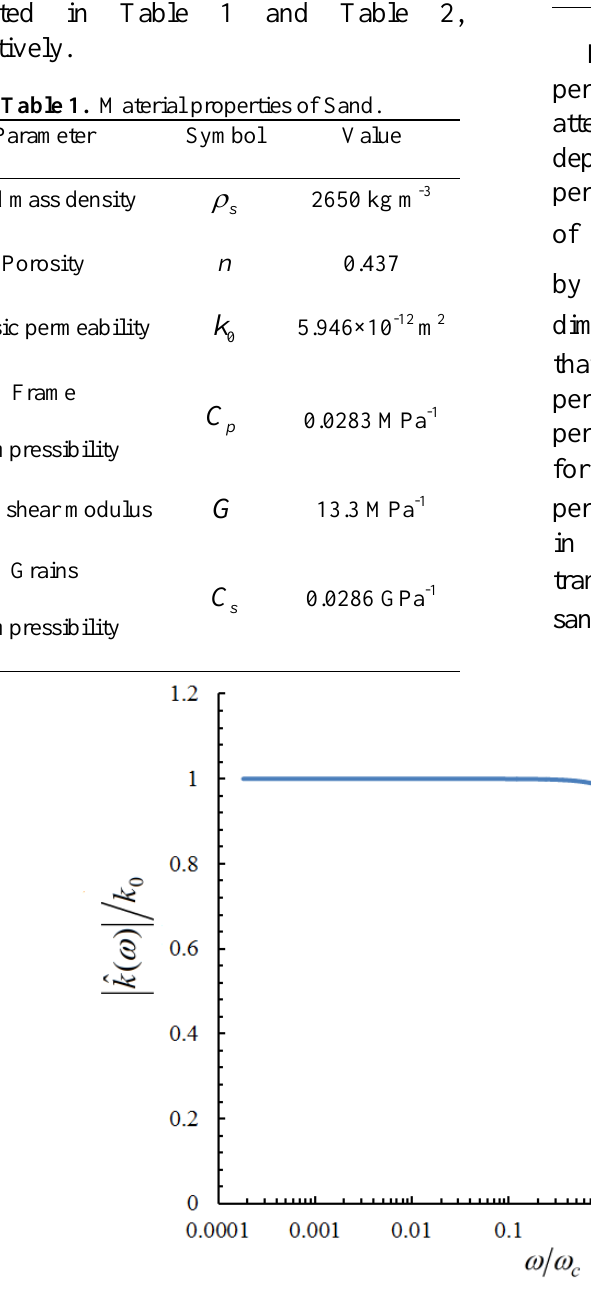
Fig. 1. Frequency-dependent